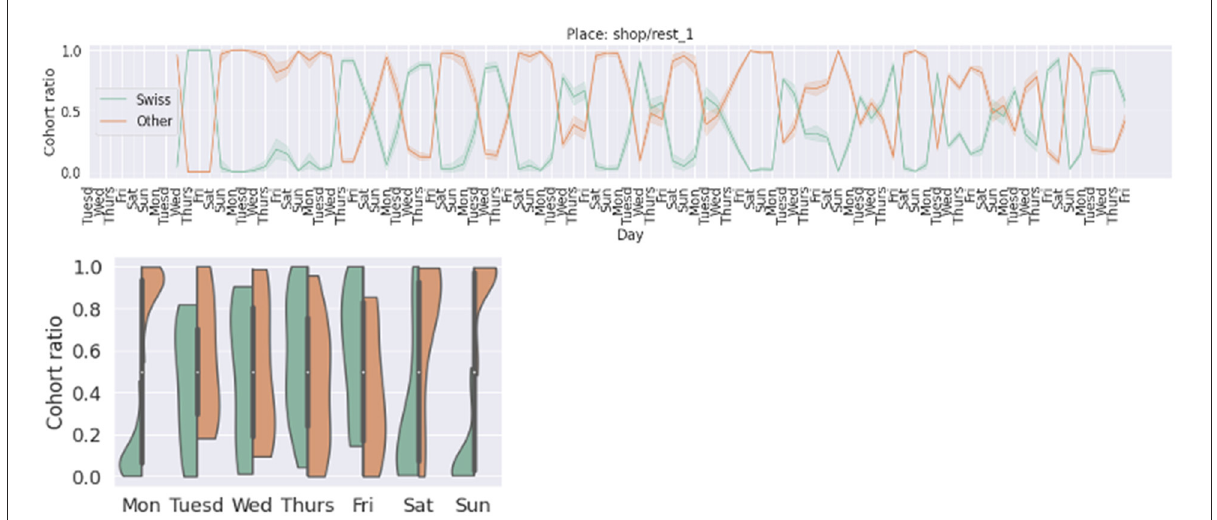
FIGURE9 Example cohort (nationality) analytics provided to place operators (analytics users). Y-axis: aggregated cohort ratio. X-axis top figure: day of the week through the 3 months study. X-axis left figure: split-violin plots for each day of the week. Green: Swiss nationality. Orange: Other nationality. Breadcrumbs